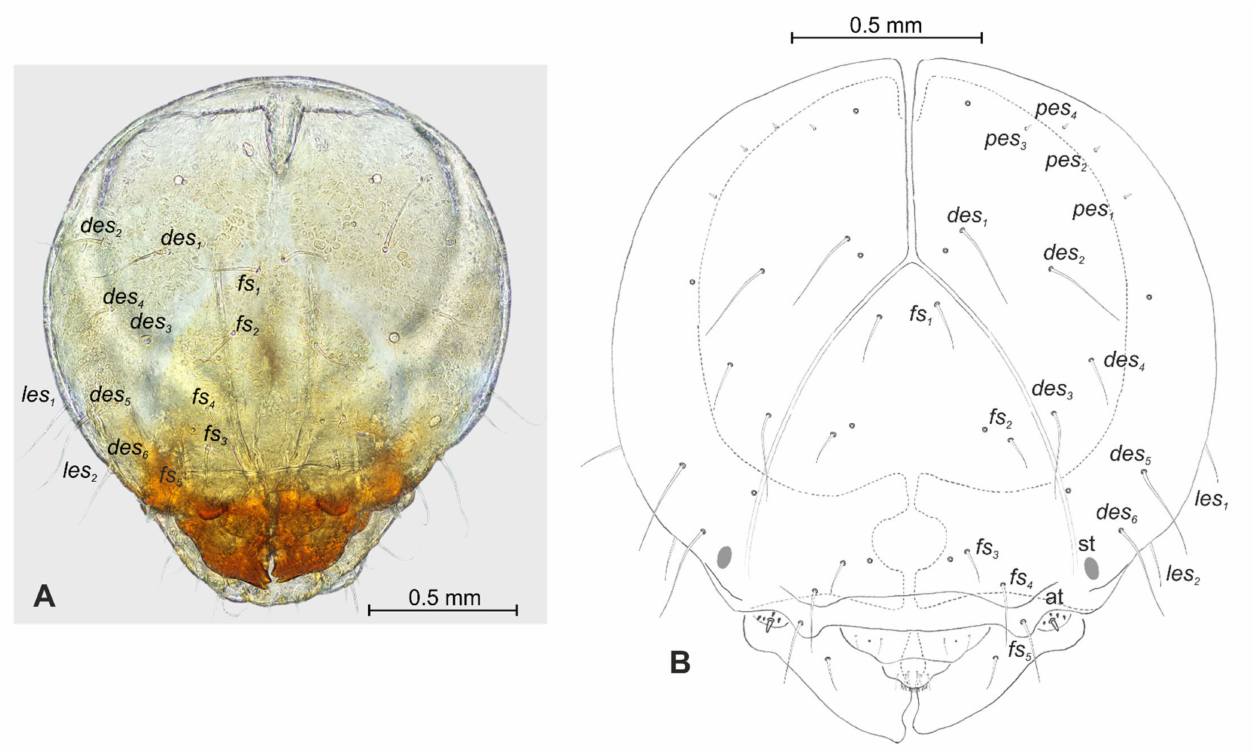
Figure 4. Lachnaeus crinitus mature larva, head. ( A )—frontal view of head, photo; ( B )—frontal view of head, scheme; (at—antenna, st—stemmata, setae: des —dorsal epicranial, fs —frontal, les —lateral epicranial, pes